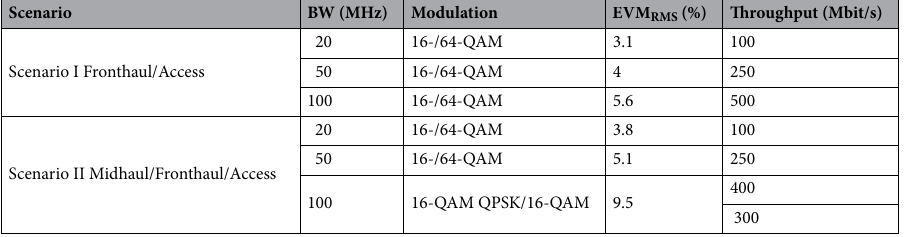
Table 2. The main 5G NR system experimental